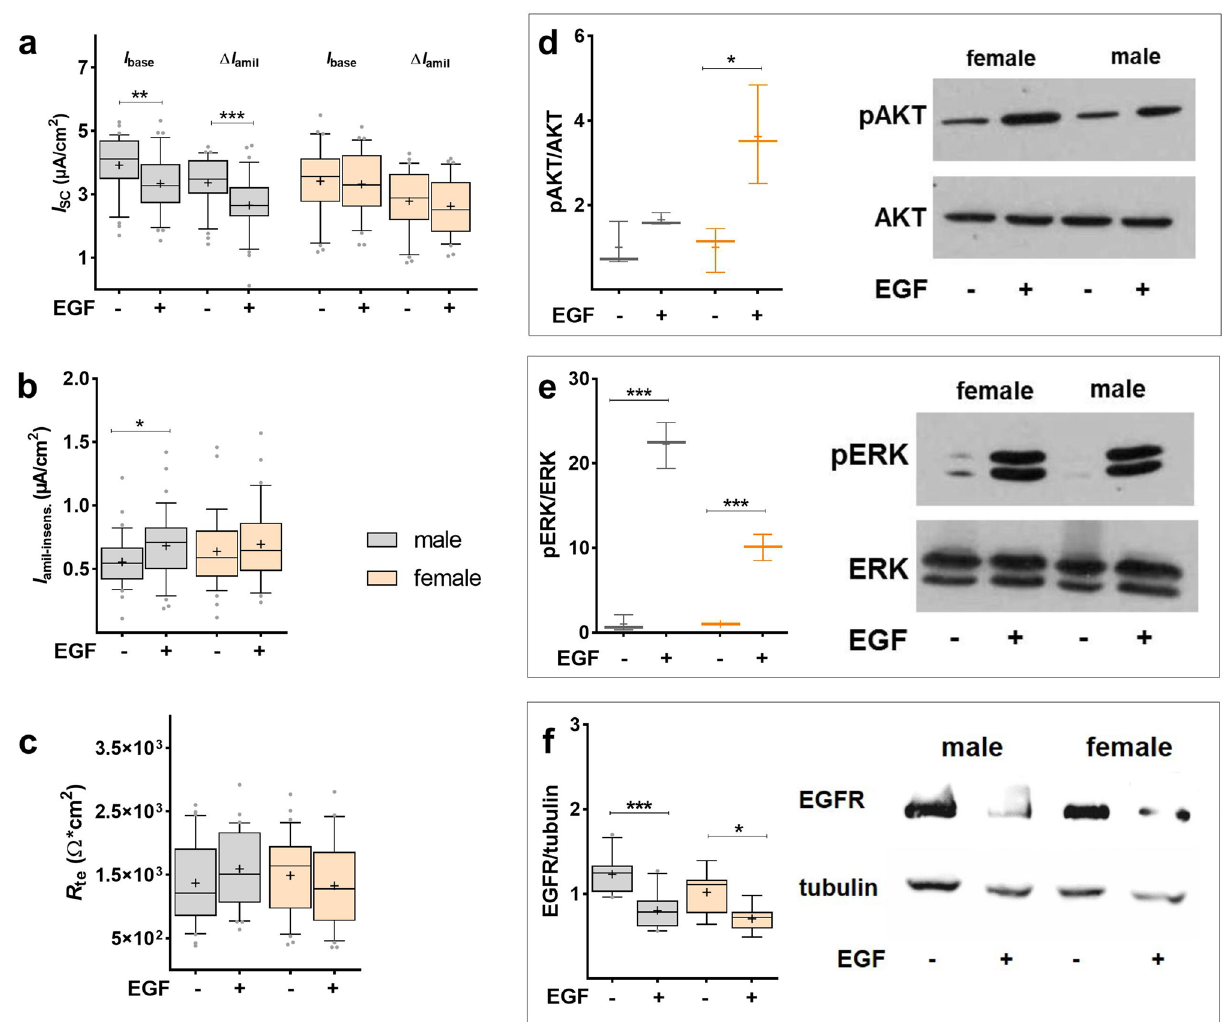
Figure 5. Acute sex-specific effects of EGF via AKT-ERK1/2 signaling. FDLE cells were cultured in SF-Med and stimulated with EGF for 45 min. Data are displayed as box and whiskers with the 10–90 percentile, mean (+) and median (horizontal line). ( a ) In male FDLE cells, EGF significantly decreased I base and Δ I amil after 45 min (n = 32–37; ** p < 0.01; *** p < 0.001 by t -test), while female FDLE cells were not significantly affected by acute EGF application. ( b ) EGF acutely increased I amil-insens in male FDLE cells (* p < 0.05), while R te ( c ) was not affected within the experimental time frame. ( d ) EGF significantly increased AKT phosphorylation within 15 min only in female FDLE cells (n = 3; * p < 0.05 by t -test). ( e ) In contrast, EGF significantly increased ERK1/2 phosphorylation within 15 min in both, male and female FDLE cells (n = 3; *** p < 0.001 by t -test). ( f ) Short-term EGF exposure decreased EGFR protein expression (n = 10/9; * p < 0.05; *** p < 0.001 by t -test). (Grey boxes) male; (yellow boxes) Effects of EGF in combination with female sex steroids. Sex steroid, especially female sex steroids, have been previously shown by us to stimulate Na + transport in FDLE cells 15,29 . Whether this stimulation is affected by the presence of EGF was analyzed in male and female FDLE cells treated with E2/P and EGF, alone or in combination. Female sex steroids prevented the reducing effect of EGF on Na + transport. EGF significantly decreased Δ I amil in male FDLE cells, which was reversed by the addition of E2/P ( p < 0.05; p < 0.01; Fig. 10a). Moreover E2/P stimulated Δ I amil in females and prevented the reduction induced by EGF ( p < 0.05; p < 0.01). EGF significantly increased I amil-insens in both male and female FDLE cells, which persisted in the presence of E2/P ( p < 0.05; p < 0.001; Fig. 10b). EGF significantly increased R te as shown above, while E2/P reduced R te in male and female FDLE cells. EGF prevented this decrease of R te induced by E2/P in both male and female FDLE cells ( p < 0.01; p < 0.001; Fig. 10c). In conclusion, the presence of female sex steroids alters the response to EGF, independent of the cells’ sex. Notably, the concentration of female sex steroids in utero is equal for both sexes, as they are produced by the maternal placenta. Therefore, a sex specific effect of EGF in combination with female sex steroids is unlikely, at least for the fetal situation.